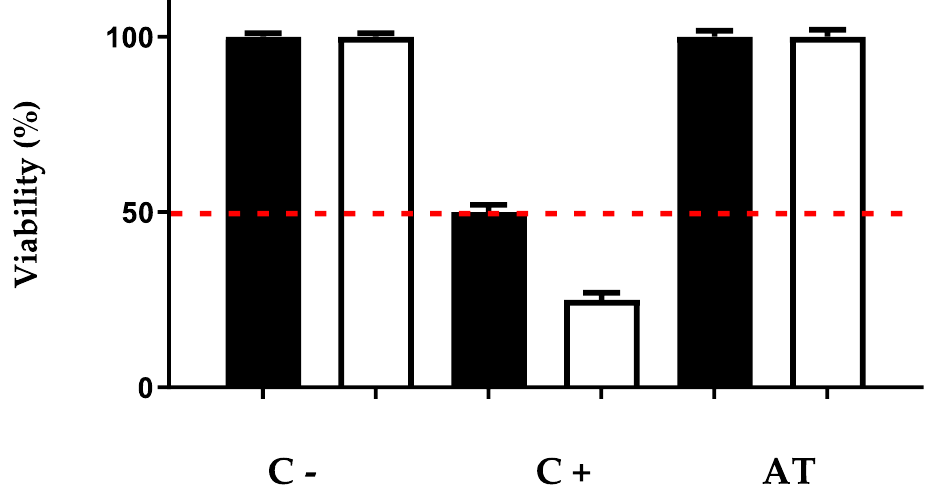
Figure 1. Test for skin corrosive potential of Arnica tincture. The bars represent the means ± SD of the percentage of cell viability after 3 min and 60 min of exposure. C-: negative control; C+: positive control; AT: Arnica tincture. Black bars: 3 min; white bars: 60 min.